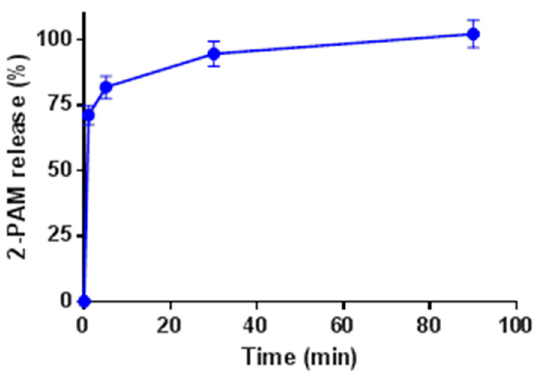
Figure 6. Release of 2-PAM from MIL-125-NH 2 in PBS at 37 °C as a function of time. The concentration at 90 min was 240 μ g mL − 1 . The error bars represent the coefficient of variation on the measurement.